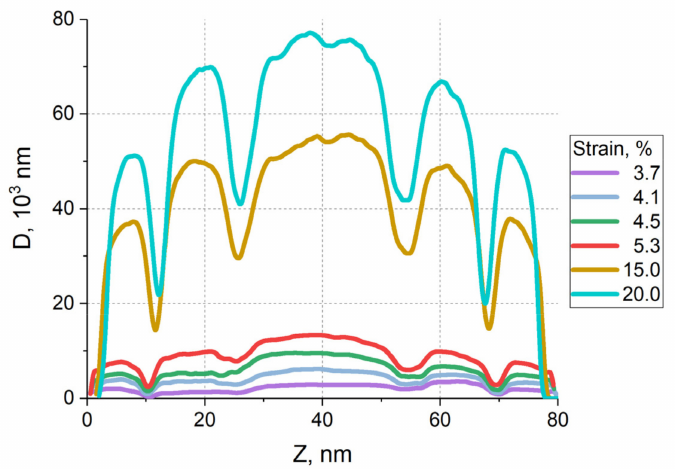
Figure 4. Z-axial distribution of the total displacement parameter D in grains for different tensile strains in the